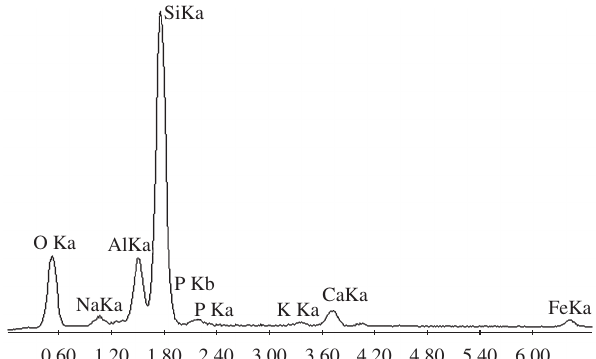
Figure 5. Scanning electron spectral analyses of a zeolite.